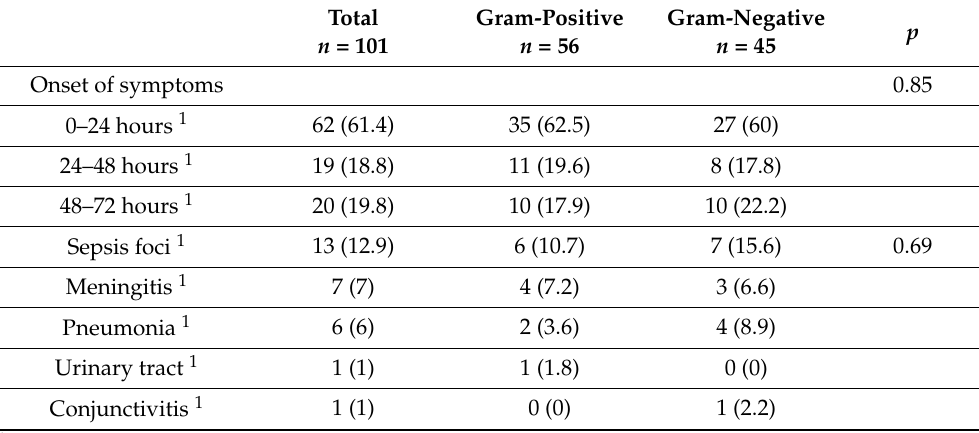
Table 4. Time of onset of symptoms and sepsis foci in